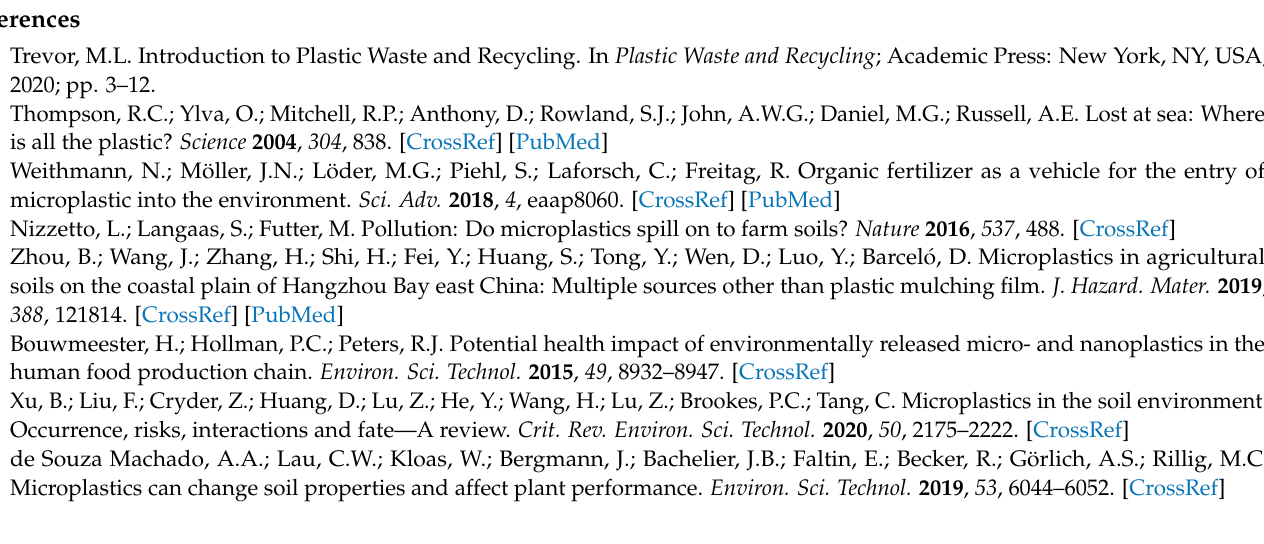
Figure S4: Effect of single and combined toxicity of PP MPs and Cd on vigor index of rice seeds, Figure S5: Effect of single and combined toxicity of PP MPs and Cd on germination rate of rice